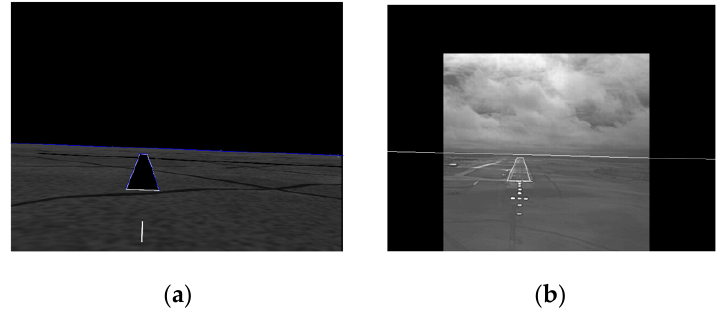
Figure 2. The runway and horizon detected in the ( a ) SVS image and ( b ) EVS image.